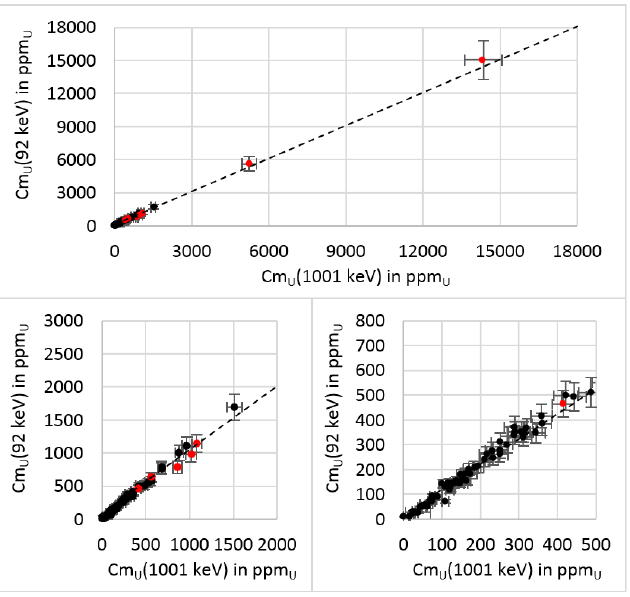
Fig. 4. Uranium content